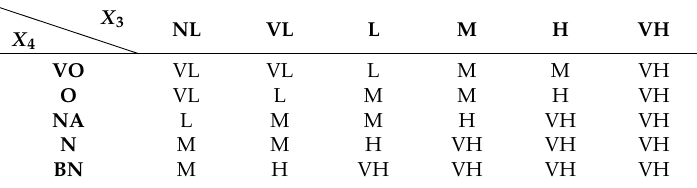
Table 2. Fuzzy rules in partial 2 FIS.